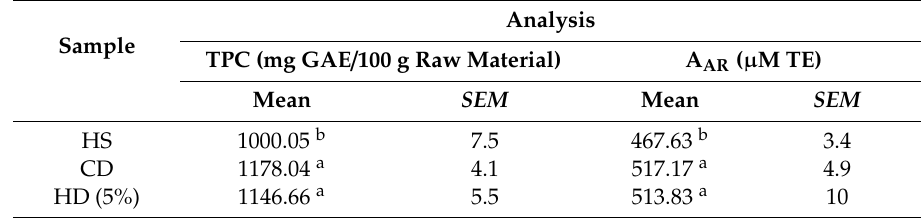
Table 1. Total polyphenol content and antiradical activity of hemp seed and experimental